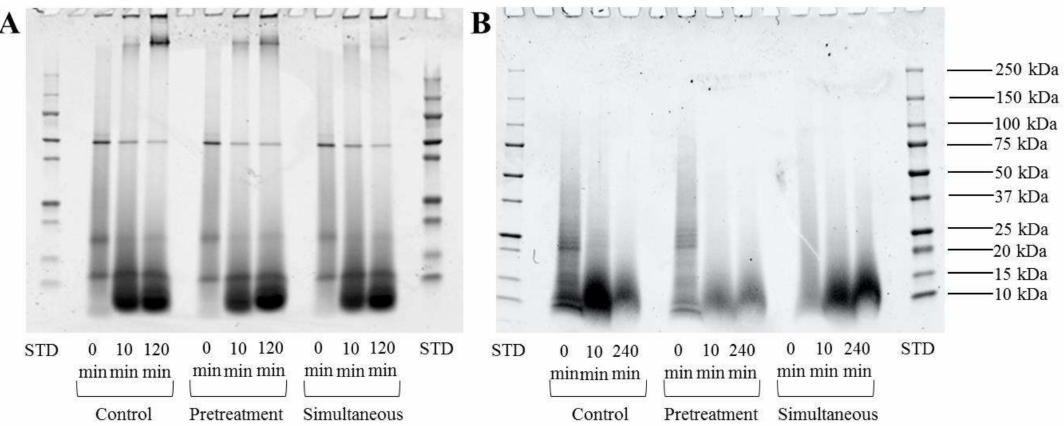
Figure 1. Protein degradation of mealworm proteins during enzymatic hydrolysis by Alcalase ® ( A ) and pepsin ( B ) for control (0.1 MPa) and pressurization conditions (pretreated and simultaneous at 380 MPa for 1